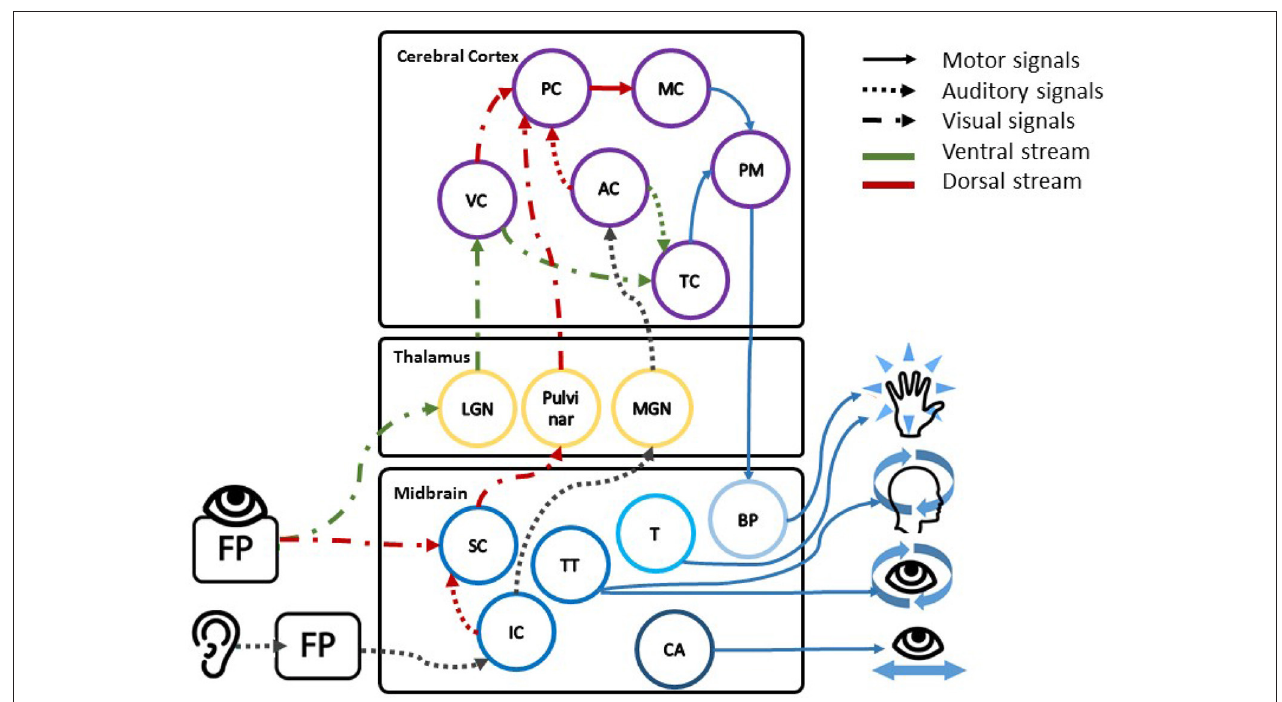
FIGURE 1 | The figure shows the schematic description of the close link between areas in the midbrain processing spatial information, directing movement and the two processing streams. The first stage of combined spatial processing is found in the tectum with the visual spatial information in the superior colliculus (SC); the auditory spatial information in the inferior colliculus (IC); and the direction of head and eye movement in the tectospinal tract (TT). In direct neighborhood the cerebral aqueduct (CA) controls the eye, the eye focus and eyelid movements. The tegmentum (T) on the other side is responsible for reflexive movement, alertness, and muscle tone in the limbs (Waldman, 2009). Following the processing in the midbrain, visual and auditory spatial information is forwarded to the lateral geniculate nucleus (LGN), the pulvinar, and the medial geniculate nucleus (MGN) respectively, followed by the according visual and auditory cortii (VC, AC). Within the two cortii spatial and feature information is separated into the ventral stream (green) across the temporal cortex (TC) and dorsal stream (red) across the parietal cortex (PC). Decisions on motor reaction are then executed by the motor cortex (MC), the premotor cortex (PM), and the basis pendunculi (BP) in the midbrain ( Stein et al., 2004; Malmierca and Hackett,